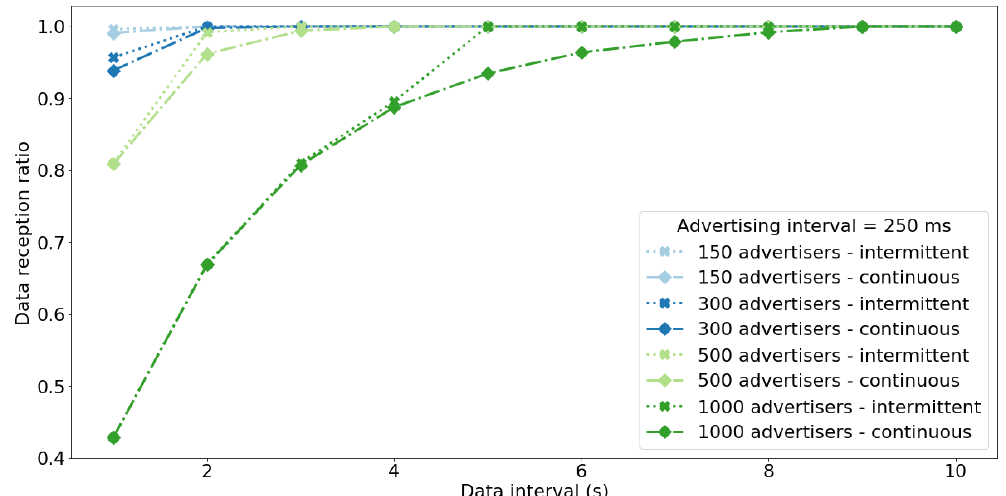
Figure 8. Median of the DRR τ for different data intervals τ , network sizes, and the advertisement interval equal 250ms. For dense networks and short data intervals the DRR drops to the same values for both continuous and intermittent operation modes.